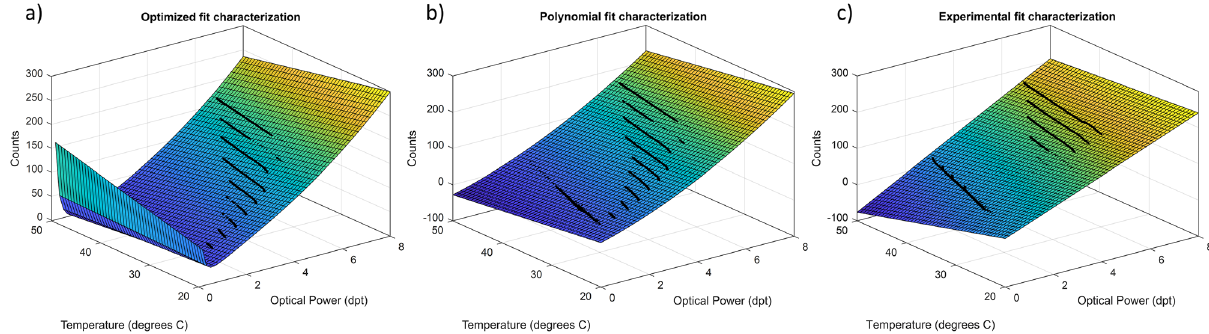
Figure 10. Graphical representation of the 3D fitting models tested as a compensation method for temperature effects on the TL. Optimized model ( a ), Polynomial model ( b ), and experimental model ( c